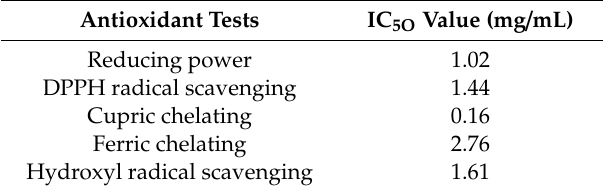
Figure 4. Antioxidant potential of A. sisalana agro-industrial residue extract. AsRE = A. sisalana agro-industrial residue extract; ** p < 0.01 and *** p < 0.001 by two-way ANOVA, followed by a Sidak’s multiple comparisons test. The assay was carried out in three independent experiments, performed in triplicate. The results were expressed as mean ± DP. Table 1. IC 50 values of Agave sisalana agro-industrial residue extract obtained from antioxidant tests.